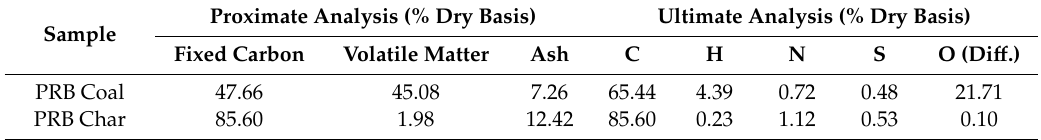
Table 1. Proximate and ultimate analysis of the Powder River basin (PRB) sub-bituminous coal and char.